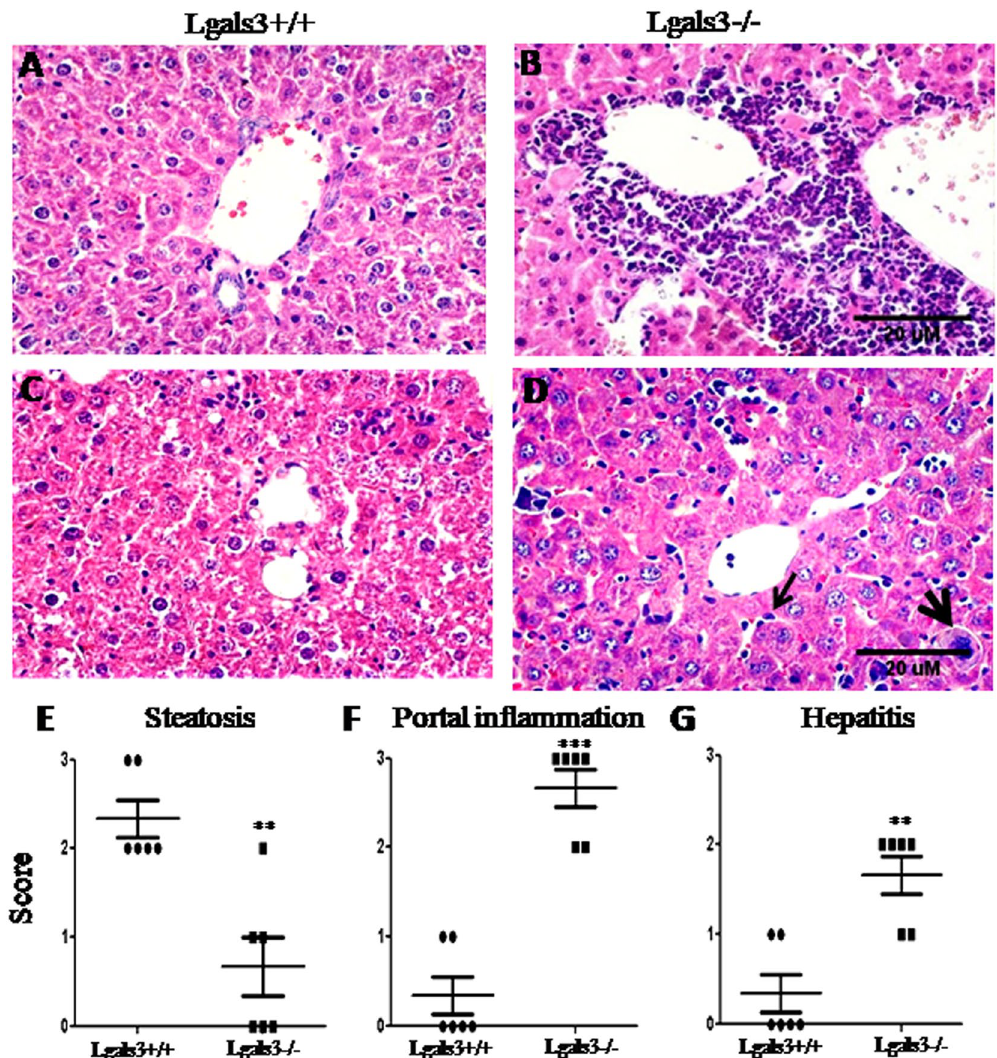
Figure 8. Photomicrographs of liver on pristane-induced mice. Representative images of livers obtained from Lgals3 + / + and Lgals3 − / − mice both treated with pristane for 6 months. ( A ) Portal zone of Lgals3 + / + mice showing absence of inflammation. ( B ) Intense inflammatory infiltrate in the portal zone of Lgals3 − / − mice. ( C ) Lobular zone of Lgals3 + / + mice showing steatosis foci . ( D ) Lobular zone of Lgals3 − / − mice showing plasma cells (arrow) and megakaryocytes (arrowhead). Score to steatosis (E), portal inflammation ( F ) and hepatites ( G ) were plotted in bar graphs. Black bars indicate Lgals3 + / + mice and white bars represent Lgals3 − / − mice. Data are representative of three independent experiments. Magnification: A-D (100 × ) and E-F (500 ×